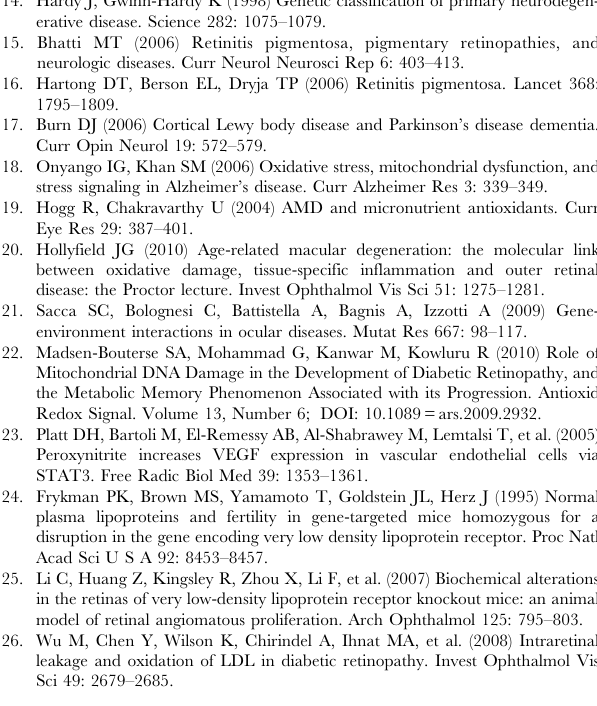
Figure S2 Photomicrographs of dihydroethidium (DHE) labeling of retinal sections. Superoxide production in retinal sections was assayed by using the oxidative fluorescent dye, DHE. DHE is oxidized on reaction with superoxide to ethidium bromide which binds DNA in the nucleus and fluoresces red. There was no discernable difference in the DHE-labeled retinas from Vldlr-/- and WT mice. GCL= ganglion cell layer; INL =inner nuclear layer; ONL= outer nuclear layer. (TIF) Text S1 Experimental Details and Results for Characterization of